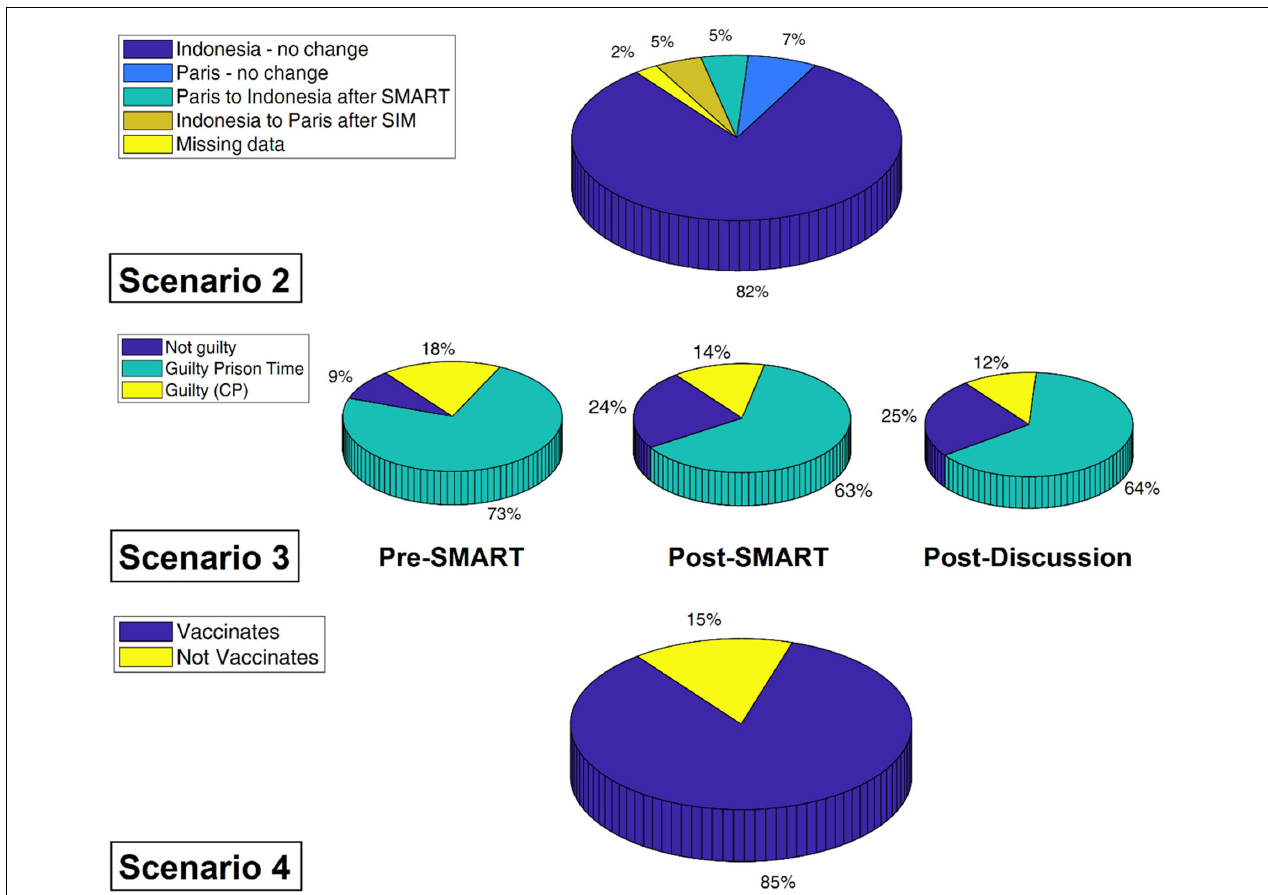
FIGURE 1 | Percent of participants holding each stance on scenario issues.